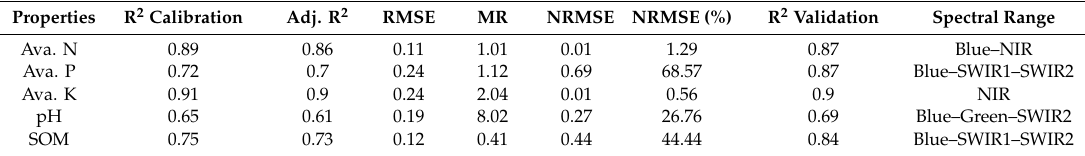
Table 4. Statistical parameters of soil properties (N, P, K, pH, and SOM).